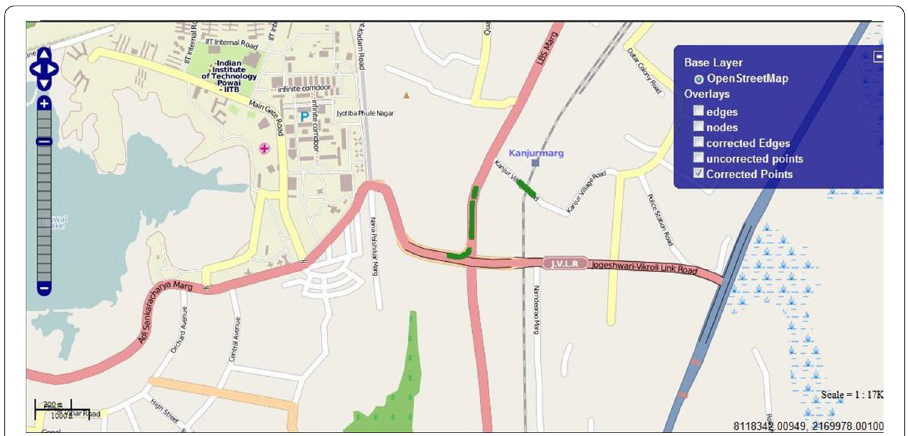
Fig. 12 GPS traces plotted over Open street